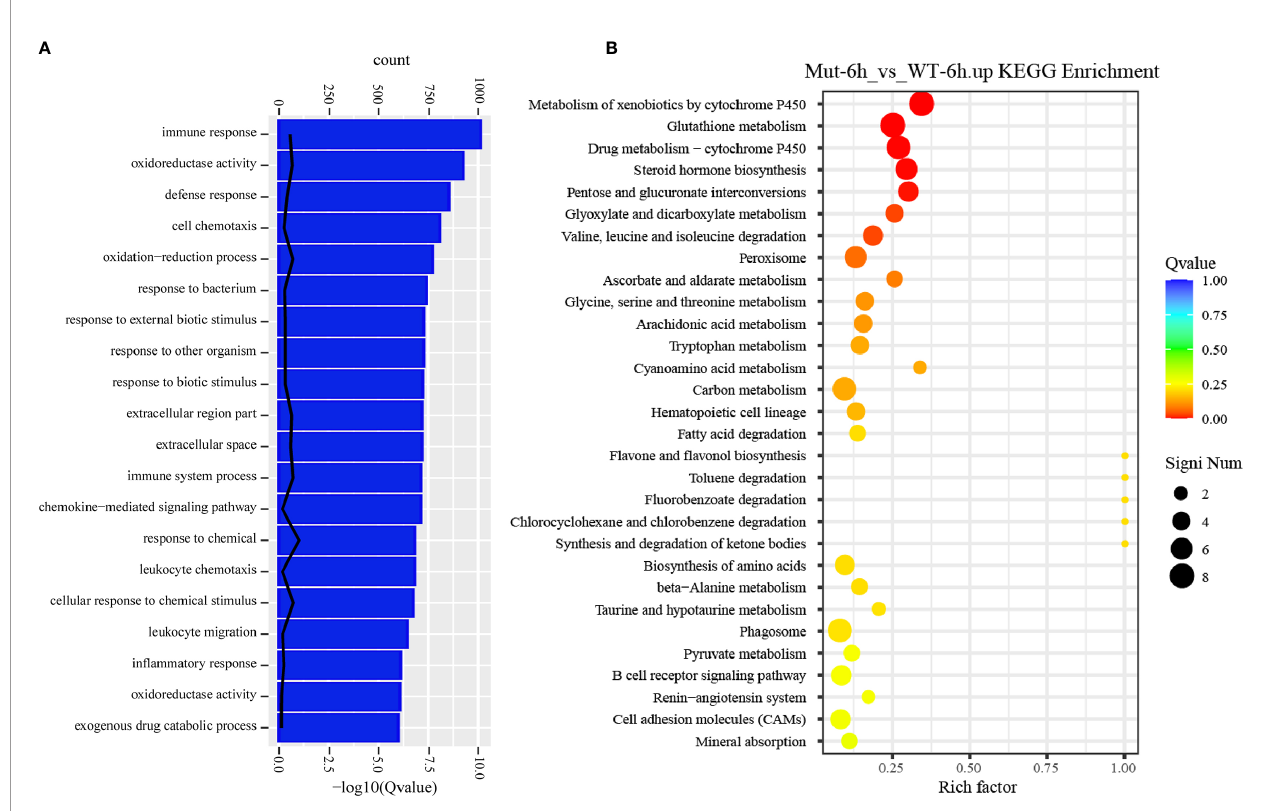
FIGURE 3 | GO functional enrichment and KEGG analysis from upregulated DEGs in Mut-6h_vs_WT-6h. (A) The top 20 signi fi cantly upregulated GO categories in Mut-6h_vs_WT-6h. The X - and Y -axes represent the signi fi cantly enriched GO terms and the corresponding number of DEGs, respectively. (B) The top 30 upregulated KEGG pathways in Mut-6h_vs_WT-6h. The numbers of DEGs in each pathway are counted and rich factors and P -values are